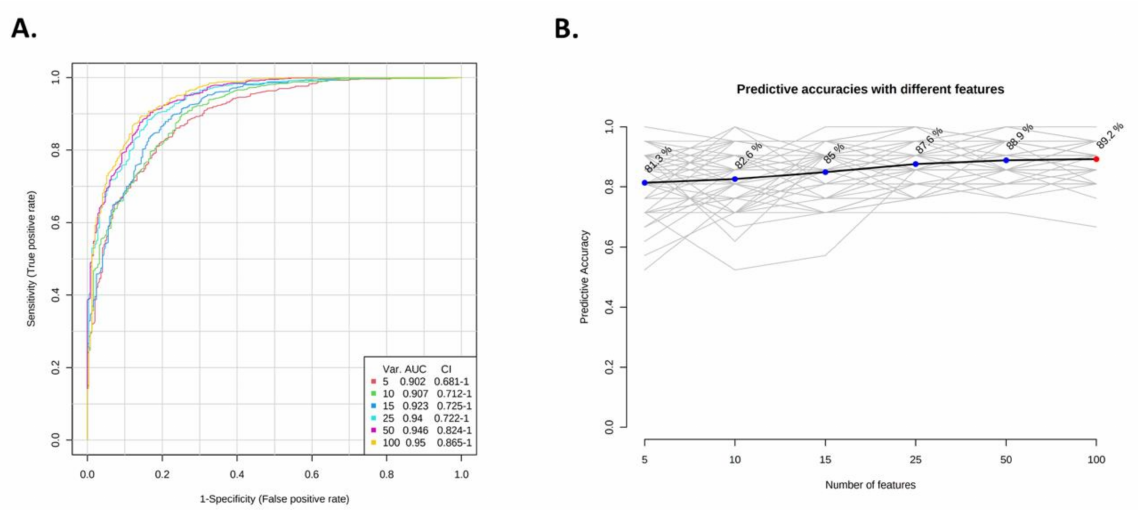
Figure 8. Model performance of six SVM classifiers with an increasing number of metabolites. ( A ) ROC curves for each SVM classifier, based on average cross-validation performance. AUCs and 95% CIs are presented in the figure legend. ( B ) Predictive accuracy for each SVM. The model with the highest accuracy is highlighted in